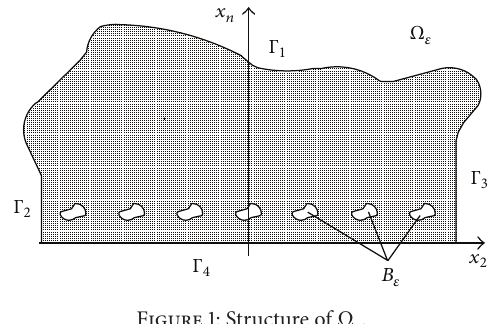
Figure 1: Structure of Ω 𝜀